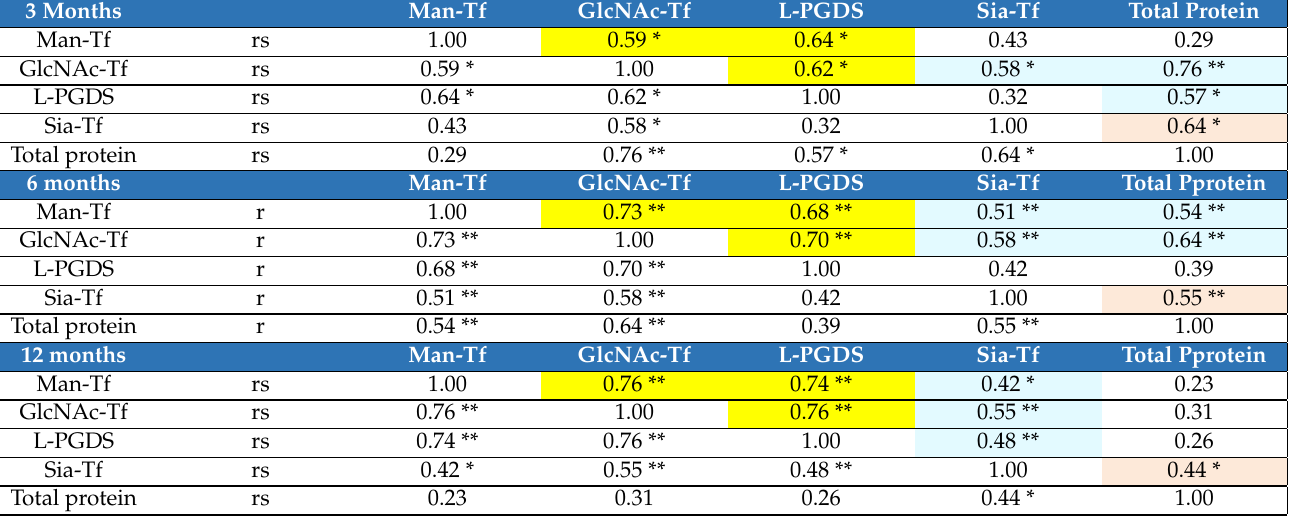
Spearman’s rank correlation coefficients (rs) for markers at 3 and 12 months and Pearson’s correlation coefficients (r) at 6 months are indicated. Coefficients among Man-Tf, GlcNAc-Tf, and L-PGDS are highlighted in yellow, those of GlcNAc-Tf vs. blood-derived proteins are highlighted in blue, and those of Sia-Tf and total proteins ( p < 0.05) are highlighted in pink. Data normality (Nor.) is indicated by a plus (+) or minus ( − ) sign. Probability level: * p < 0.05, ** p <